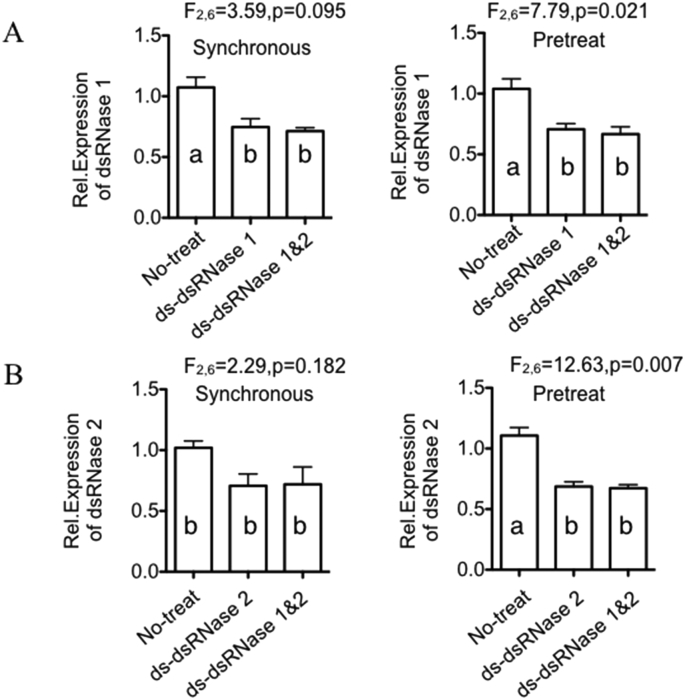
Expression of dsRNase genes in whiteflies administered ds-dsRNase1, ds-dsRNase2 or ds-dsRNase1&2. The experimental design is shown in Fig. 4A. (A) Relative expression level of dsRNase1. (B) Relative expression level of dsRNase2. Gene expression was normalized to RPL13, and mean ± s. e. from 3 replicates are shown. Different letters indicate significantly different treatments by post hoc test following one-way ANOVA.